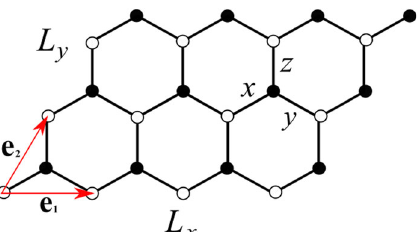
Fig. 1 The schematic three-leg cylinder on the honeycomb lattice. The open ( fi lled) circle denotes A ( B ) sub-lattice, and x , y , and z label the three different bonds. Periodic (open) boundary condition is imposed along the direction speci fi ed by the lattice basis vector e 2 ( e 1 ). L x ( L y ) is the number of unit cells in the e 1 ( e 2 ) direction.